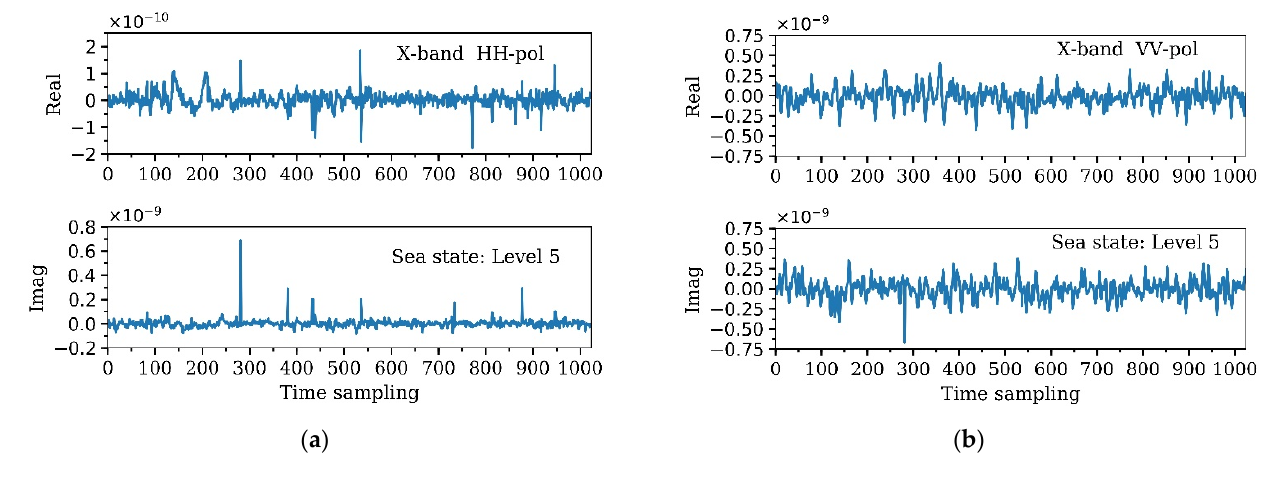
Figure 8. Time series simulation results of sea clutter with different polarizations in X-band in the Yellow Sea. ( a ) HH polarization; ( b ) VV polarization.